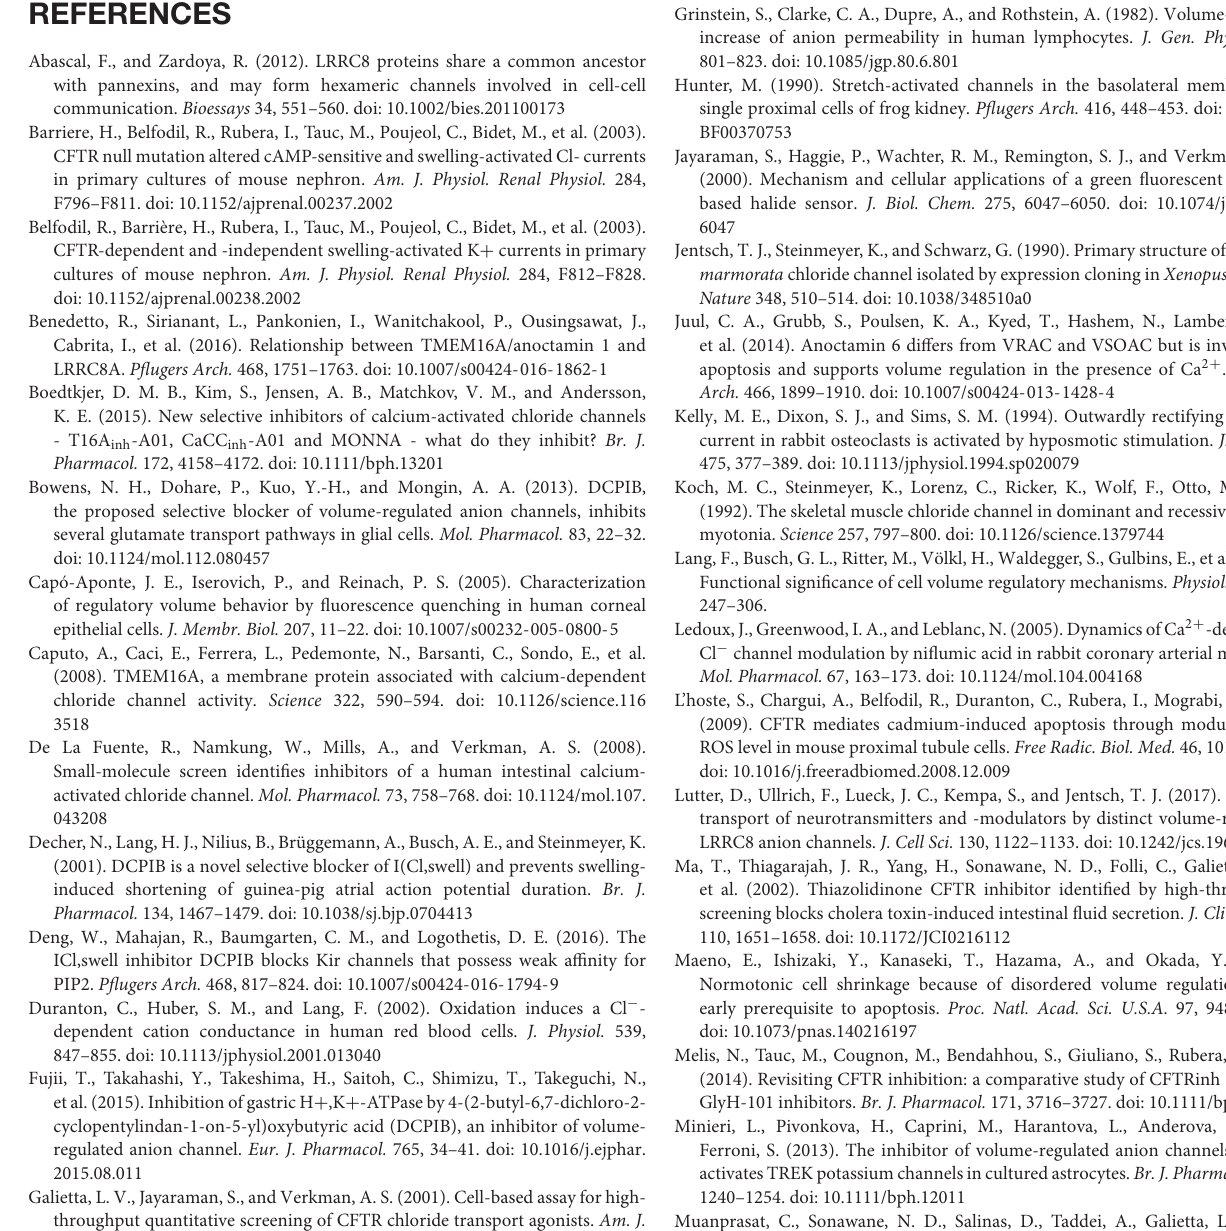
FIGURE S2 | Regulatory volume decrease as a function of hypotonic challenge intensity and polylysine coating of the plastic support. Experiments were performed using calcein relative fluorescence quenching induced by changes in cellular volume. The fluorescence emitted at 520 nm was measured every 90 s over a 60-min period. (A) After a 10-min period for fluorescence stabilization, the bath solution was replaced by an iso- osmotic solution (300 mOsm.l − 1 ) or by various hypo-osmotic solutions (200, 150, or 100 mOsm.l − 1 ). The reported values are the mean ± SEM of 6 individual experiments for each experimental condition. (B) Quantification of regulatory volume decrease following a hypotonic challenge (100 mOsm.l − 1 ) performed on cells cultured on plastic supports that were coated or not with polylysine. The values shown are the mean ± SEM of 6 individual experiments.